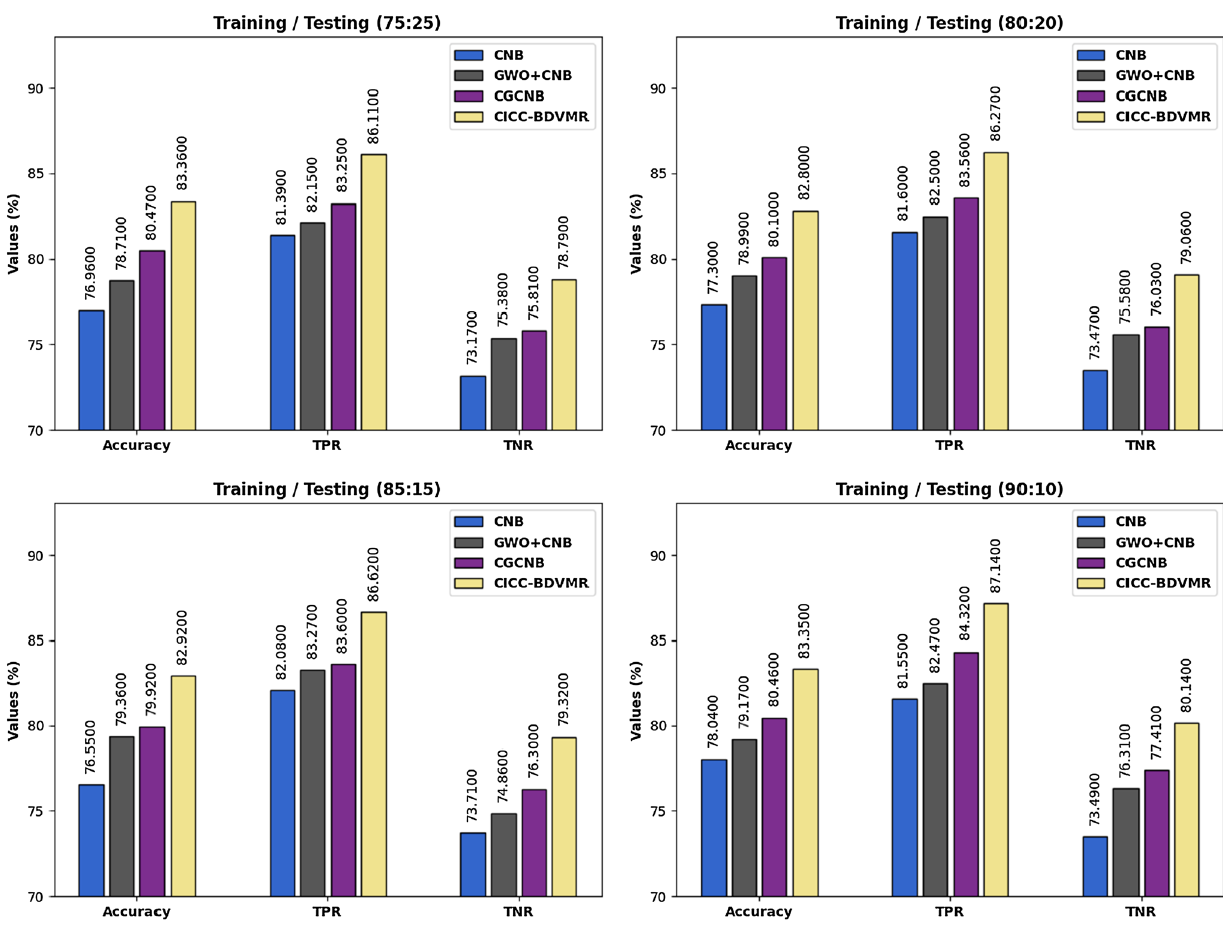
Fig. 7 Average analysis of CICC-BDVMR technique under localization data Fig. 8 Accuracy analysis of CICC-BDVMR technique under localization